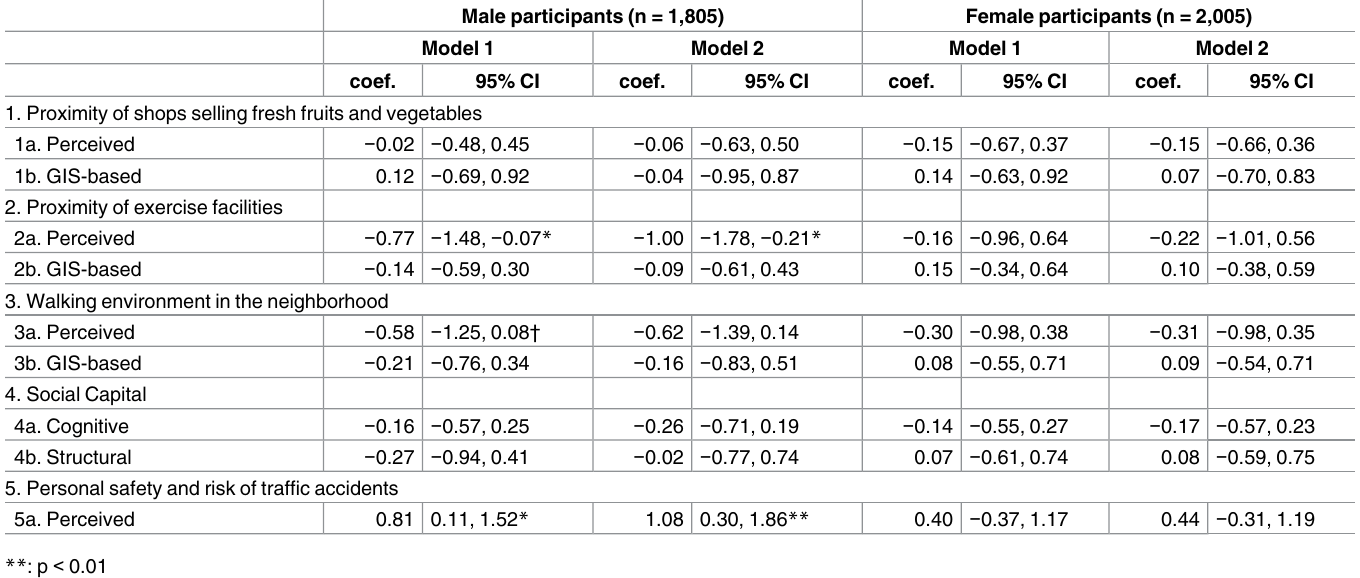
Table 3. Multilevel linear regression analysis examining the association between neighborhood characteristics and cardiovascular risk among older people living in Chita peninsula, Aichi Prefecture,